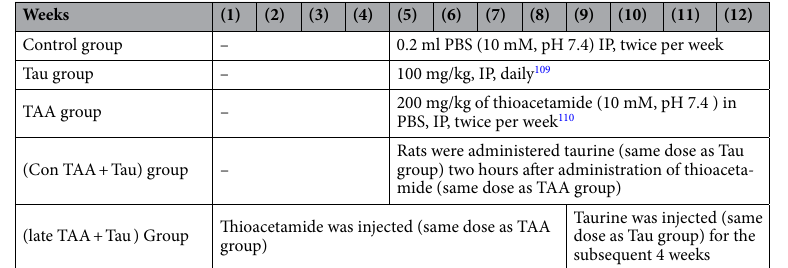
Table 2. Experimental animal design. Tau, taurine; TAA, thioacetamide; Con, concomitant.